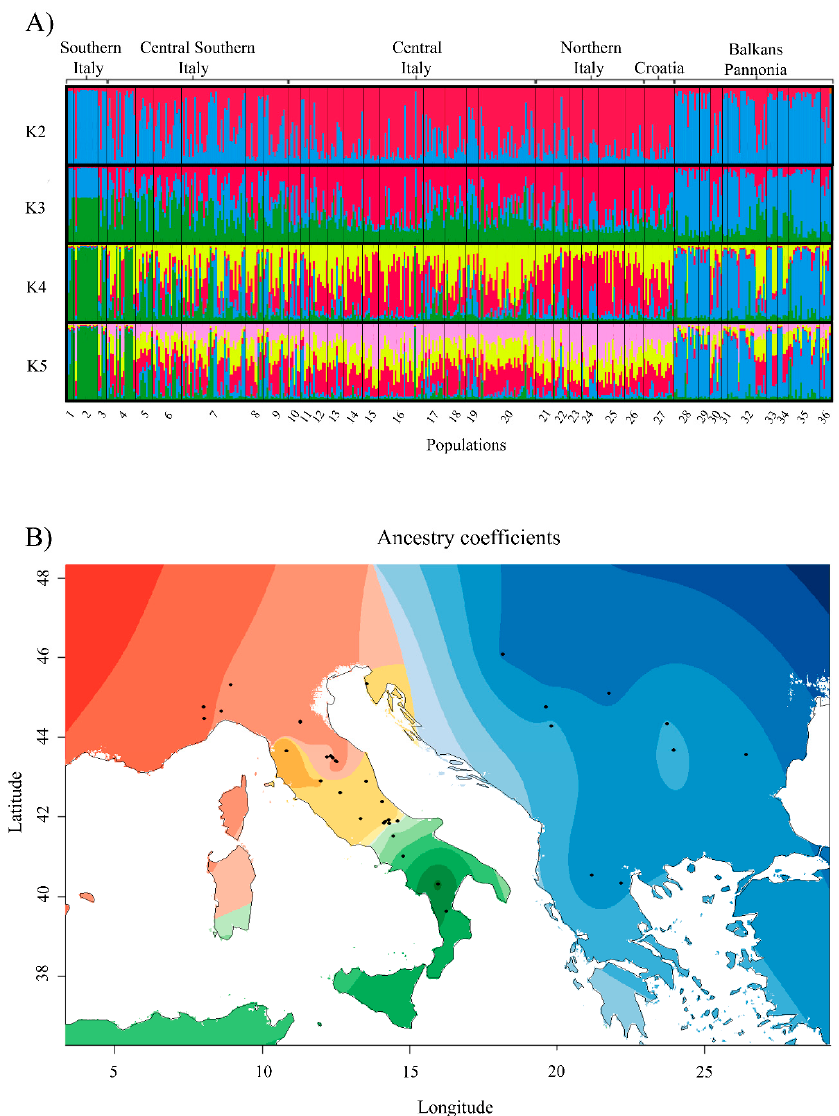
Figure 3. Bayesian analysis of genetic structure. ( A ) Plot of the ancestry coefficients of each single individual obtained with STRUCTURE based on admixture model and correlated allele frequencies. Each K is represented by a different color. Populations are indicated below the figure and their geographic origin above. ( B ) Spatial interpolation of population structure inferred for K = 4. Black dots represent the samples locations. The four K groups are represented by green, yellow, red and blue color gradients.